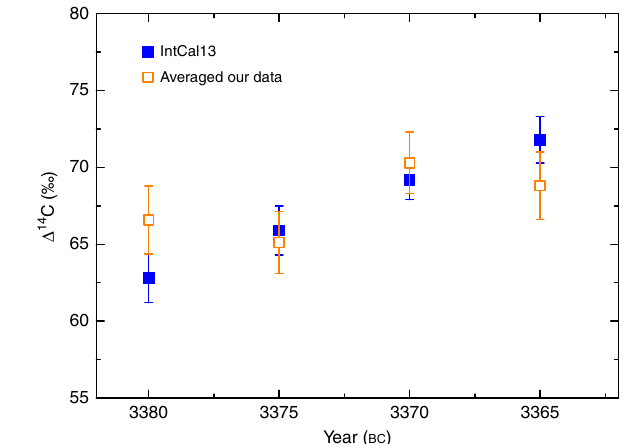
Fig. 2 Comparison with IntCal13 data. Comparison of our fi ve-year average of Δ 14 C data measured in the Beta Analytic laboratory (open squares) with the IntCal13 data ( fi lled squares) 4 . They are generally consistent with each other considering the measurement errors. Uncertainties (s.d.) of our data are based on error propagation including measurement errors of the fraction of modern carbon F . The errors of fi lled squares are adopted from IntCal13